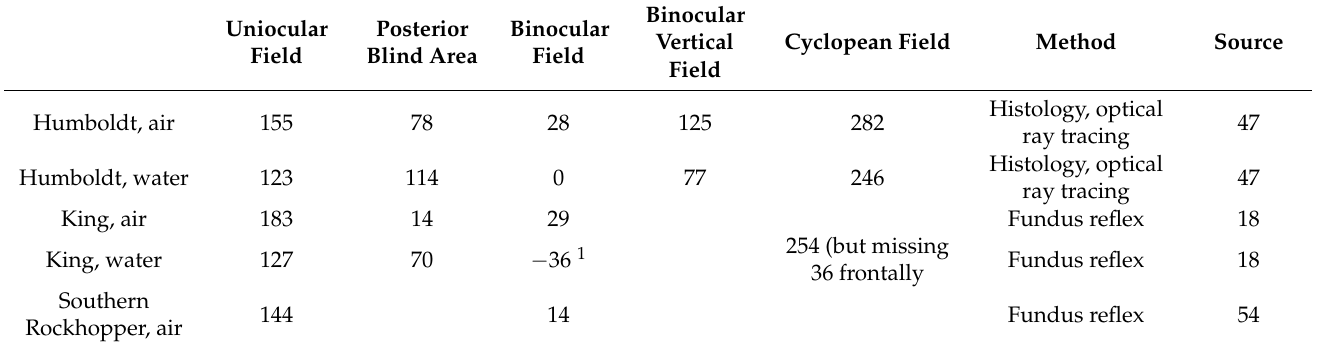
Table 1. The visual fields of the Humboldt Spheniscus humboldti [47], king Aptenodytes patagonicus [18], and southern rockhopper Eudyptes chrysocome [54] penguins in degrees. Unless noted, the fields are horizontal fields and measured in the plane of the optic axes.